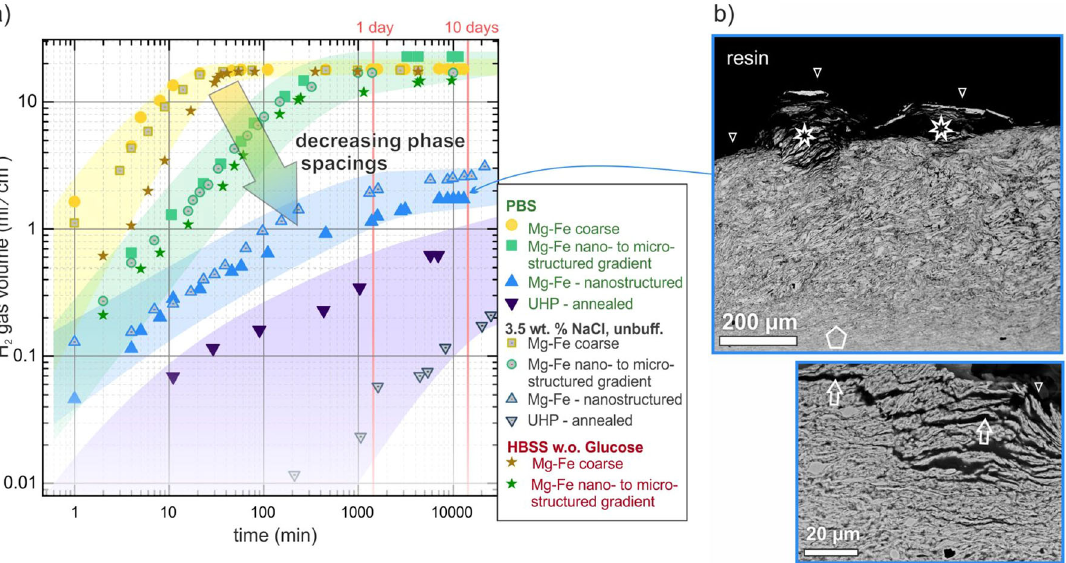
Fig. 2 Microstructure-dependent degradation rate of the Mg phase. a Time-resolved degradation, measured by H 2 evolution, of the coarse and nanostructured Mg – Fe composites compared to UHP Mg reference in three different electrolytes. For decreasing composite phase spacing, the degradation rates slow down signi fi cantly. b Cross-sectional SEM images of the nanostructured Mg – Fe composite after nine days of immersion in PBS. Triangles denote the interface with solution contact, arrows show exemplary ingress of solution (dark contrast, fi lled with embedding resin) causing lamellae exfoliation and structural bulging (stars). Pentagon marks the intact composite.